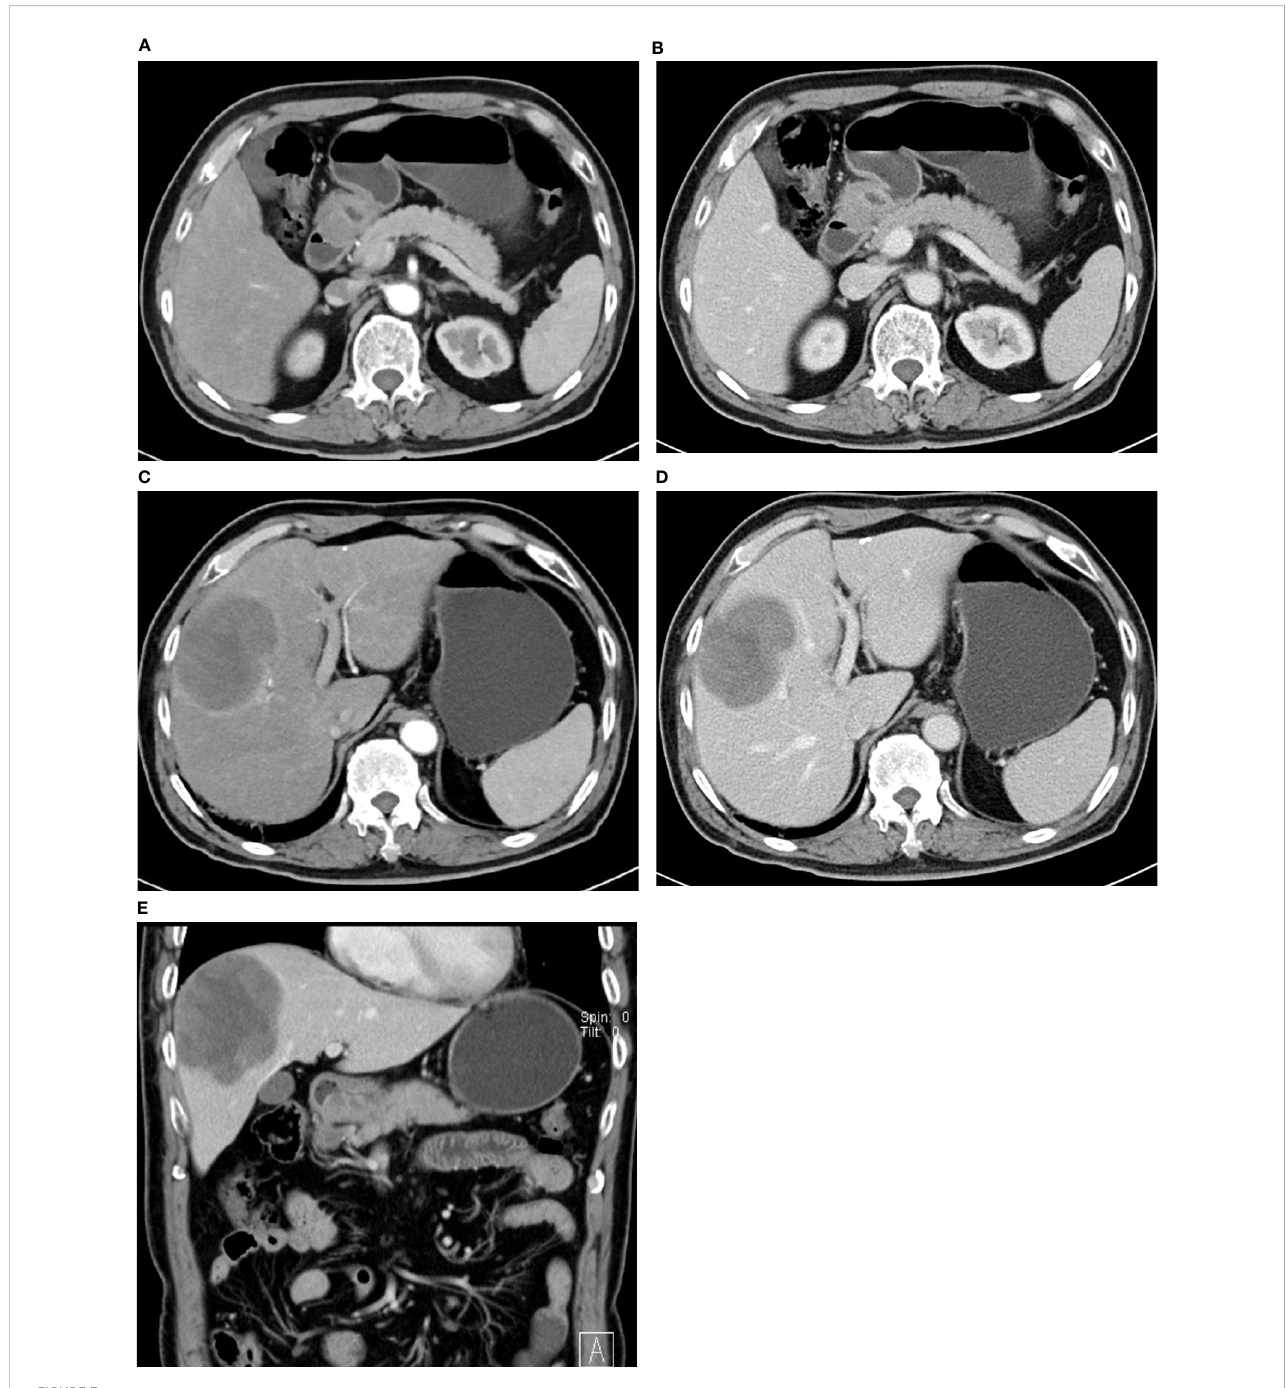
FIGURE 3 72-year-old man with HAS. Thickened wall at the gastric antrum with in fi ltrating ulceration. Continuous mild-to-moderate enhancement in the arterial phase (A) and venous phase (B) . (C, D) shows continuous a mild-to-moderate enhancement of mass in the right hepatic lobe in the arterial phase and portal venous phase. Sagittal view (E) shows ulceration at the gastric antrum and metastatic lesions in the right